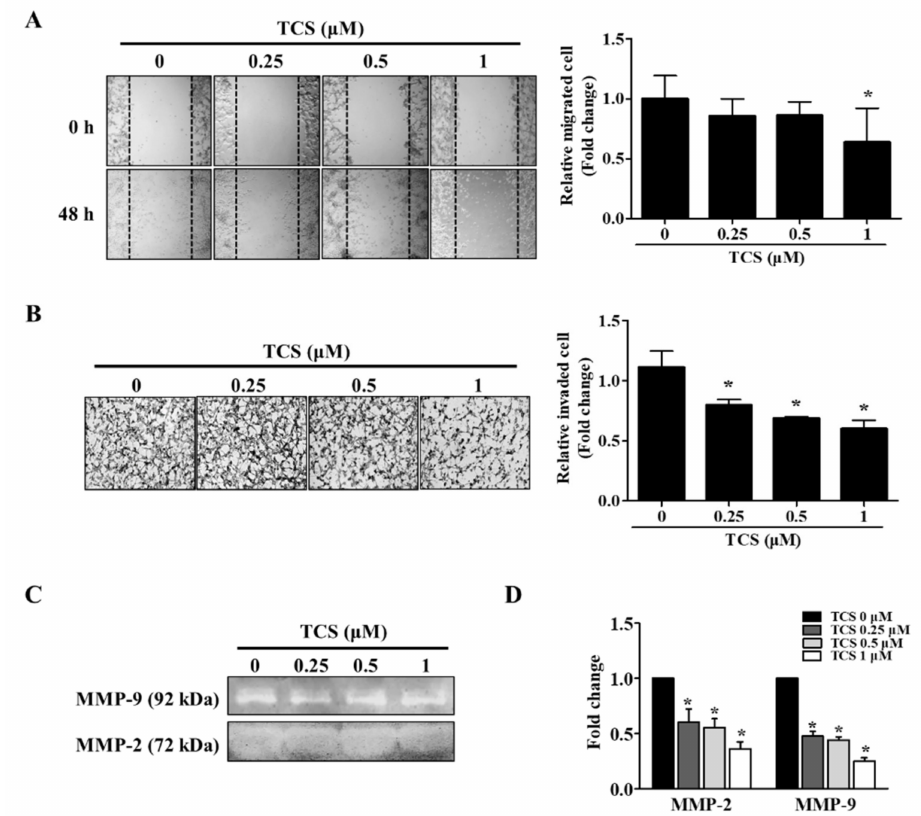
Figure 7. TCS reduces the migratory and invasive abilities of CT26 cells. ( A ) Wound healing assay. Images were pho- tographed using a microscope (200 × magnification). Quantitative analysis for migration was measured by Image J as average fold change in width of the wound at 48 h compared to that at 0 h. ( B ) Invasion assay. Images of the invasion assay were photographed using a microscope (400 × magnification). Photographs are representative of three independent experiments. Quantitative analysis for the invasion assay counted cells that invaded the membrane by Image J and presented as the relative ratio. ( C ) Gelatin zymography. Matrix metalloproteinase (MMP)-2 and MMP-9 activity in TCS-treated CT26 cells were determined. ( D ) mRNA expression levels of MMP-2 and MMP-9 were determined after TCS treatment for 48 h. Results are expressed as the mean ± SD of three independent experiments. * p <